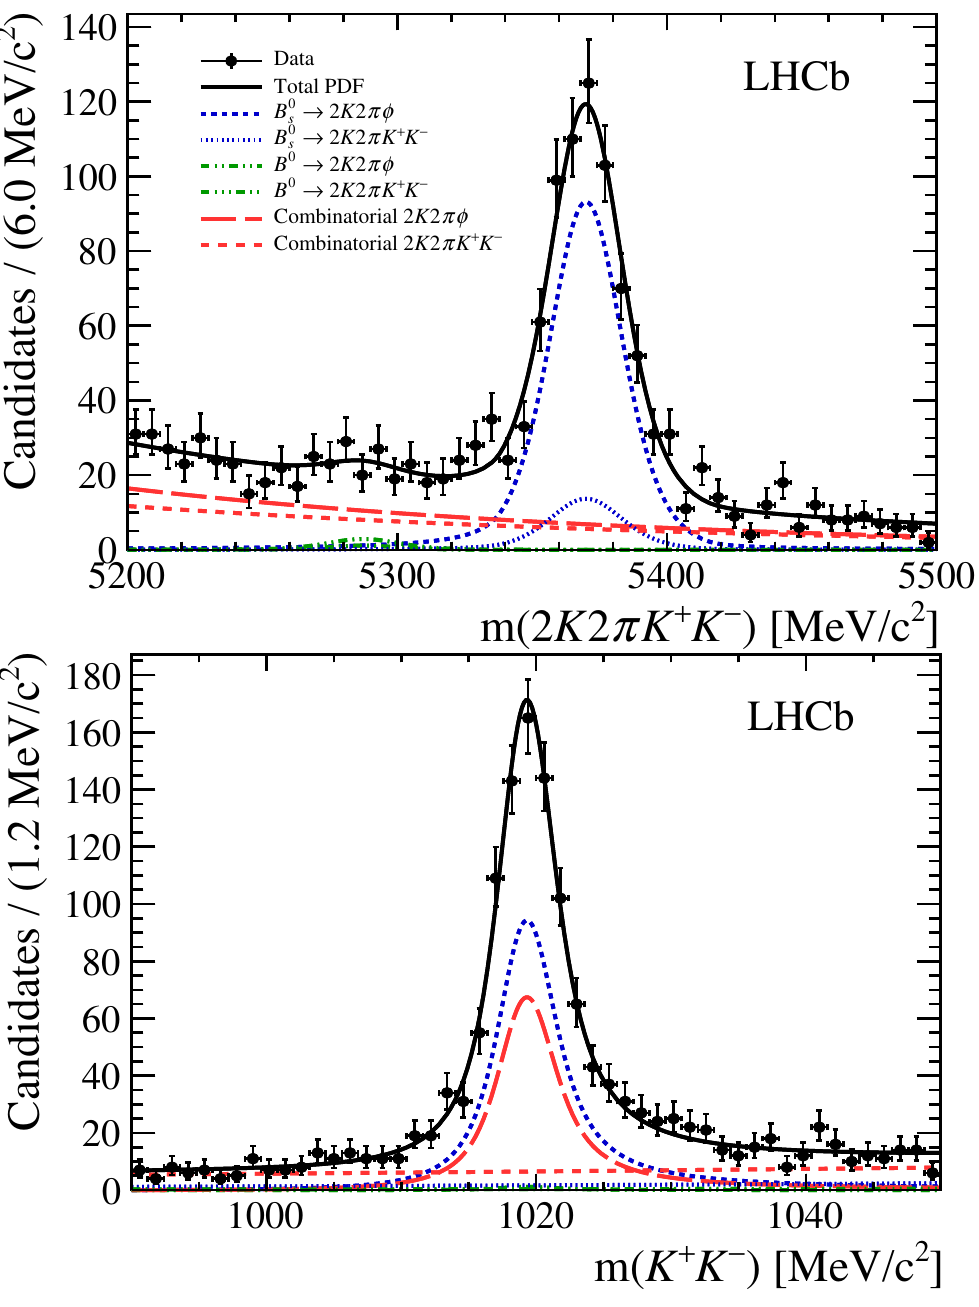
Figure 7 . Distribution of the 2 K 2 (cid:25)K + K (cid:0) (top) and K + K (cid:0) (bottom) invariant masses. Points with error bars show the data. The solid black curve is the projection of the total (cid:12)t result. The short-dashed and dotted blue curves show the B 0 ! 2 K 2 (cid:25)(cid:30) and B 0 ! 2 K 2 (cid:25)K + K (cid:0) contribu- s s tions, respectively. The long-dashed and medium-dashed red curves show the contributions of the combinatorial background with prompt (cid:30) and NR K + K (cid:0) , respectively. The dashed-double-dotted and dashed-triple-dotted green curves show the B 0 ! 2 K 2 (cid:25)(cid:30) and B 0 ! 2 K 2 (cid:25)K + K (cid:0) contribu- tions, respectively.